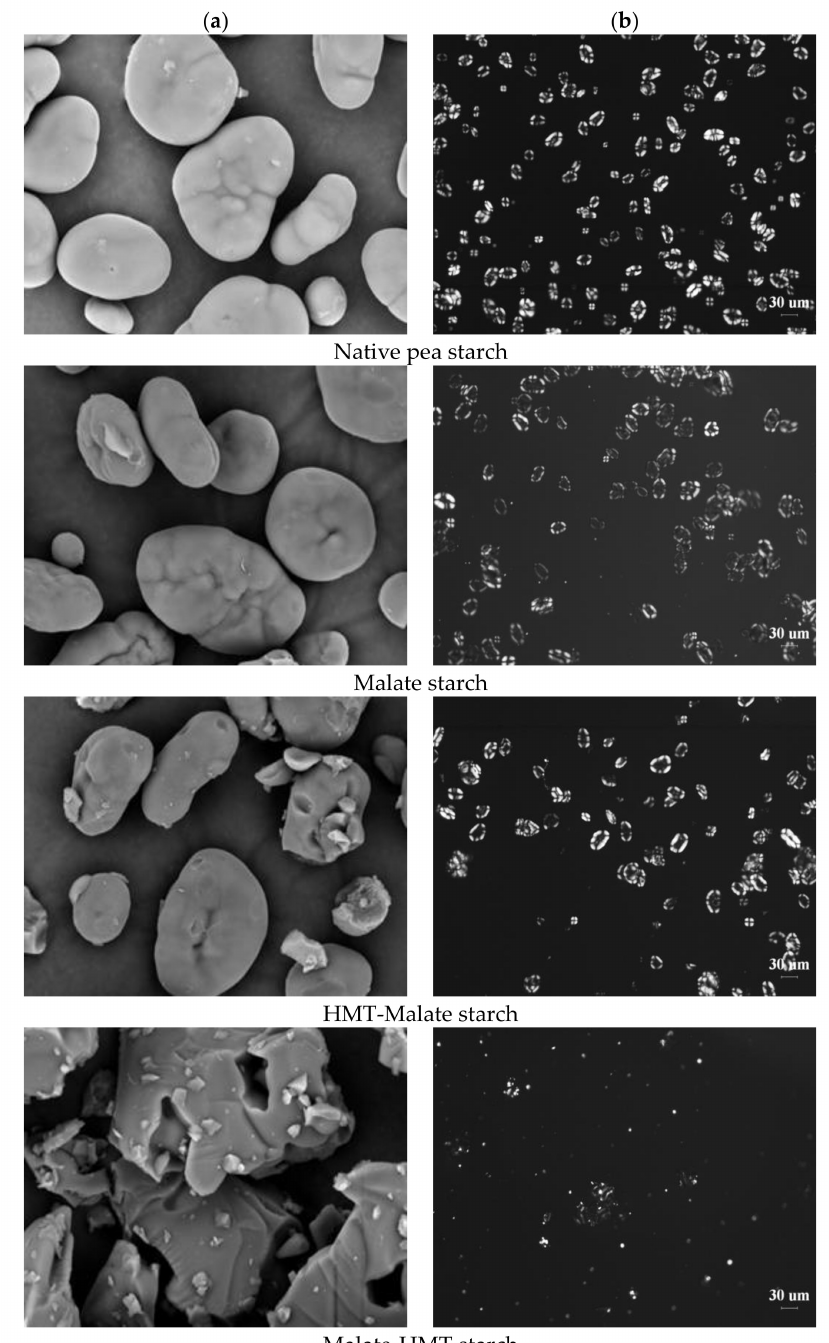
Figure 1. SEM images (1500 × ) ( a ) and birefringence images ( b ) of malate starch samples. HMT: heat–moisture